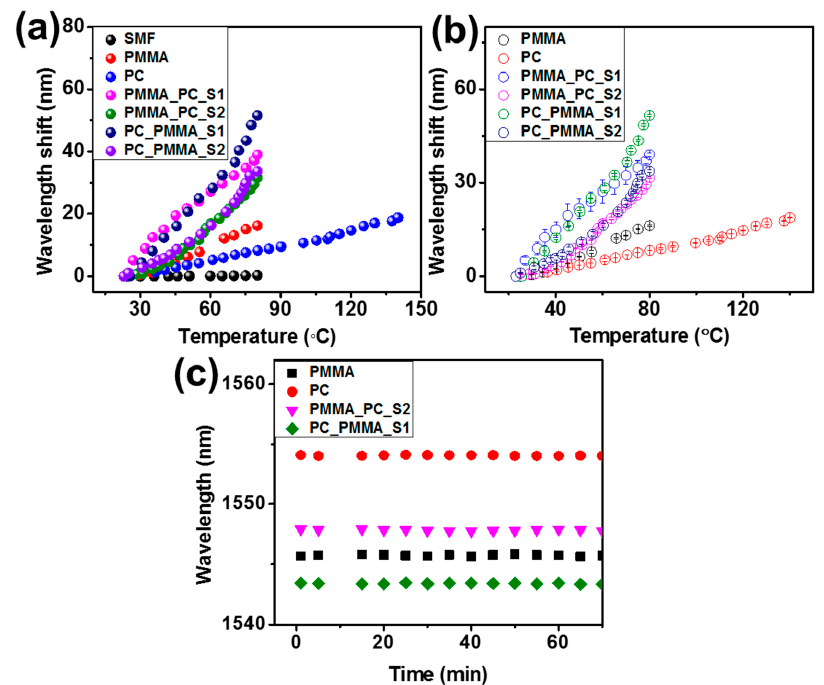
Figure 9. ( a ) Average wavelength shift compared with SMF, ( b ) results of wavelength shift and the standard deviation of the three measurements of PMMA ‐ SPFPI, PC ‐ SPFPI, PMMA_PC ‐ S1, PMMA_PC_S2, PC_PMMA_S1, and PC_PMMA_S2 DPFPI sensors, and ( c ) results of wavelength fluctuation of PMMA ‐ SPFPI, PC ‐ SPFPI, PMMA_PC_S2, and PC_PMMA_S1